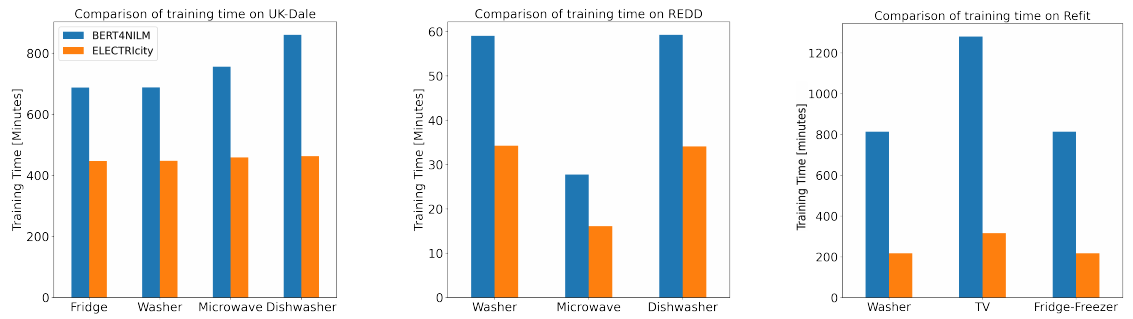
Figure 5. Training time comparison between transformer architectures on UK-Dale, REDD and Refit datasets. Averaging accross all datasets, our approach delivers a training time decrease of